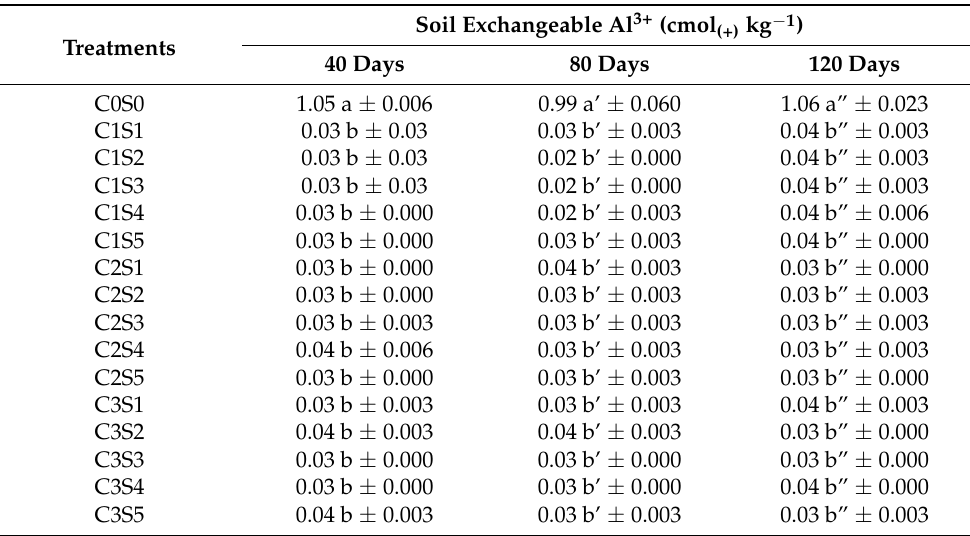
Means (value ± standard error) with different letters within the same column indicate significant differences using Tukey’s test with p ≤ 0.05. Small letters, small letters with ’, and small letters with ” indicate mean comparison at forty, eighty, and one hundred and twenty days incubation, respectively.